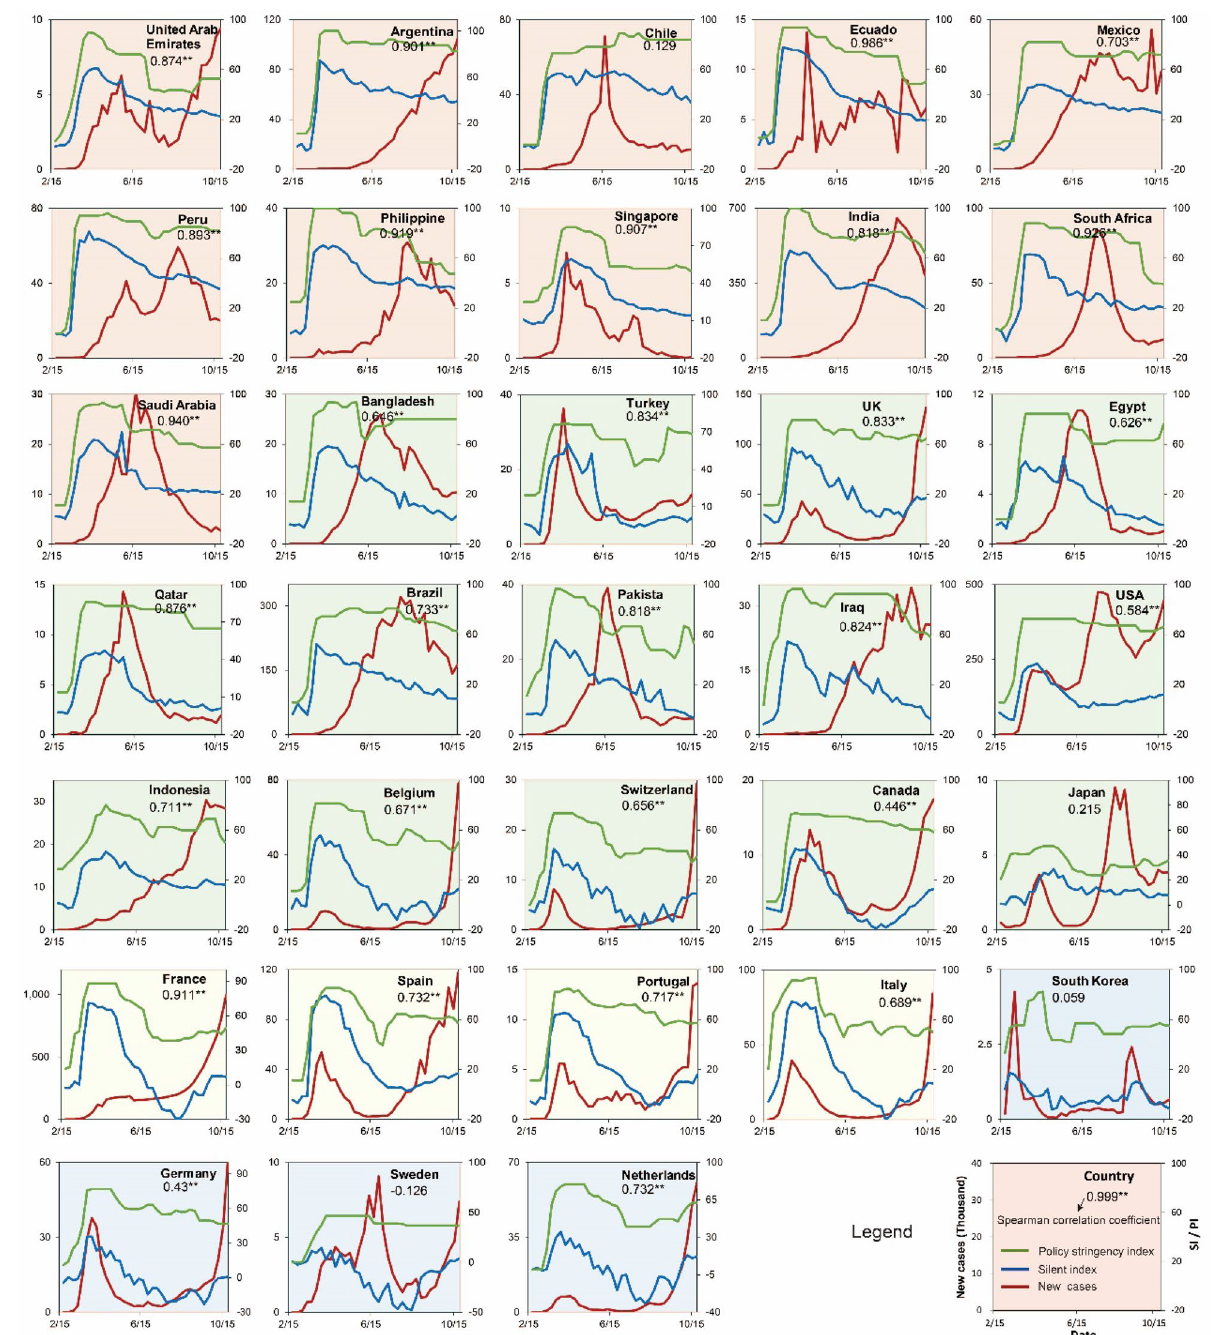
Figure 3. Temporal variation of SI, the new COVID-19 cases, and policy stringency index by country. Four groups across the countries are clustered with different colors by dendrogram in the heatmap of SI (see Fig. S1 and Table S1). Spearman correlations between SI and PI are labeled for each country, and **Means a significant correlation at the 0.01